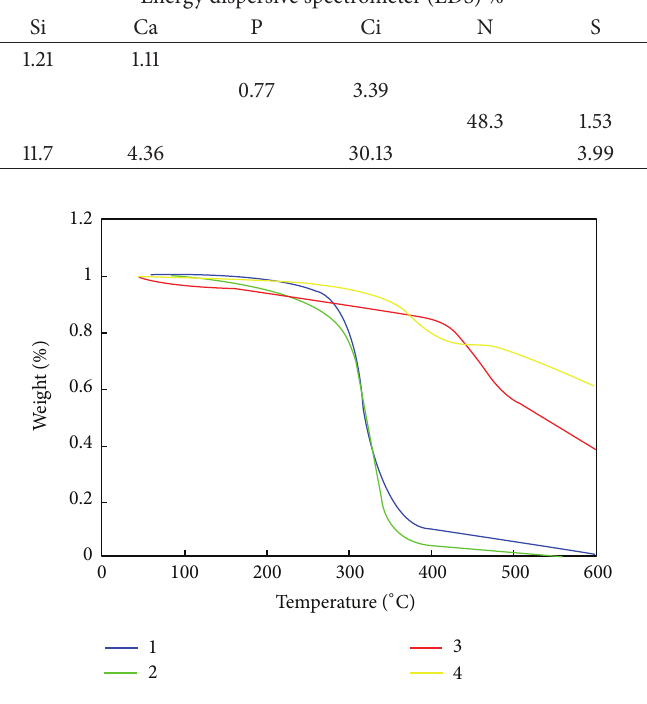
Figure 4: Thermal weight loss of different fireproof foams